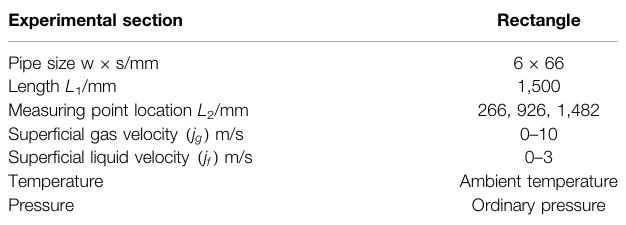
TABLE 1 | Experimental parameters of the rectangular channel. Experimental